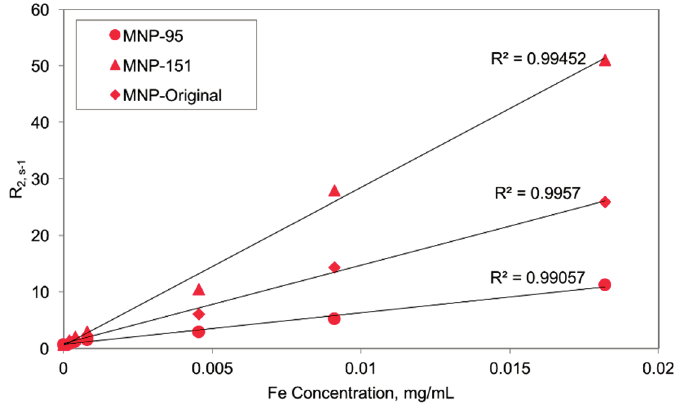
Figure 6. Transverse relaxivity R 2 values for the MNP-95, MNP-151, and MNP-O distributions with respect to iron concentration. R 2 values determined using linear trend